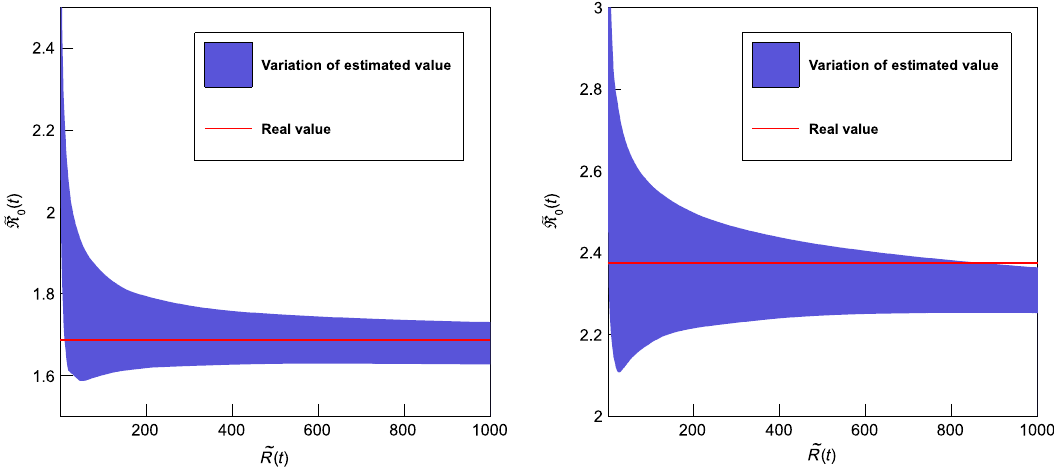
FIG. 9. The estimated basic reproduction number for the binomial (left panel: z 1 ¼ 5 , (cid:1) i ¼ 0 : 127 71 , and (cid:1) r ¼ 0 : 25 ) and exponential (right panel: (cid:5) ¼ 4 ) networks in terms of the number of removed individuals. The red line corresponds to the real value of the basic reproduction number. The blue area shows the variation of the estimated value for a hundred different realizations.